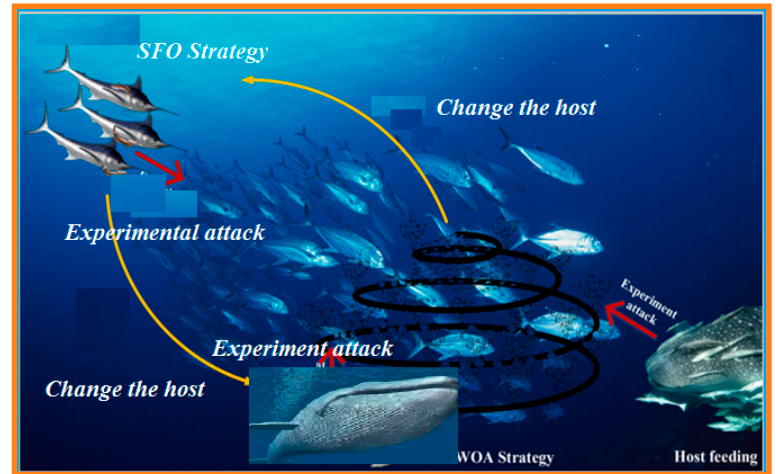
Figure 3. Different situations of